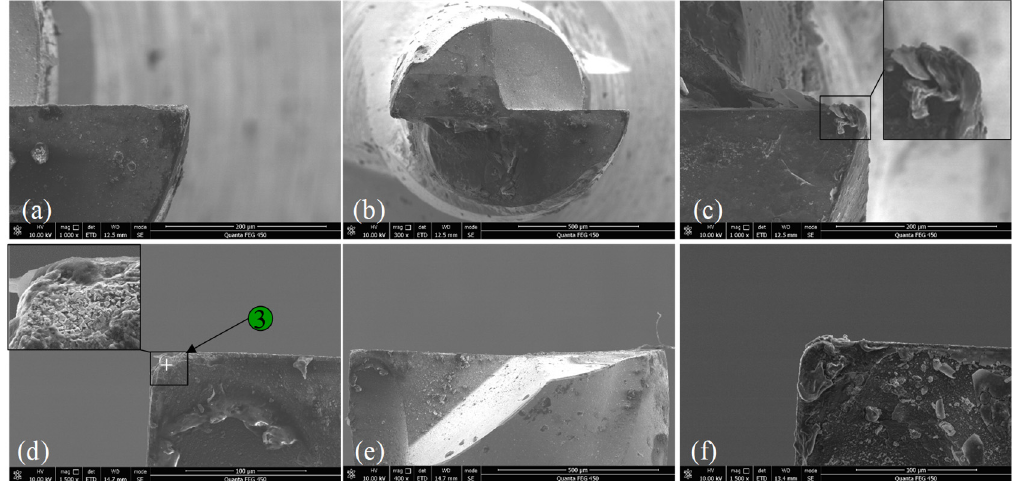
Figure 9. The tool microstructure after milling 300 mm for the aluminum workpiece. ( a ) Corner 1 bottom view; ( b ) macro bottom view; ( c ) corner 2 bottom view; ( d ) corner 1 side view; ( e ) macro side view; ( f ) corner 2 side view.